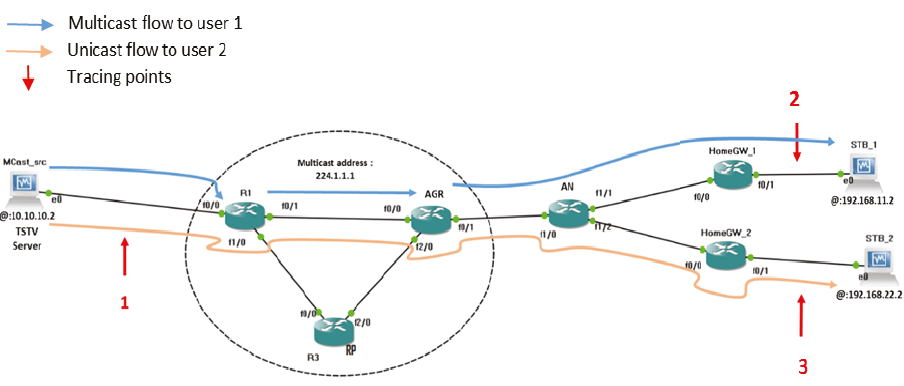
Figure 11: Typical IPTV system emulated on GNS3: IPTV multicast and TSTV flow of two users.